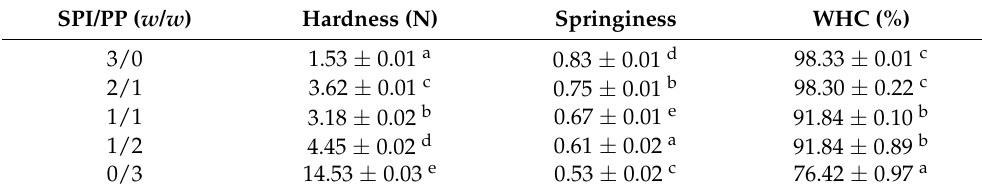
Table 1. Hardness, springiness, and WHC of composite gels at different SPI and PP ratios. SPI/PP ( w / w ) Hardness (N) Springiness WHC (%) 3/0 1.53 ± 0.01 a 0.83 ± 0.01 d 98.33 ± 0.01 c